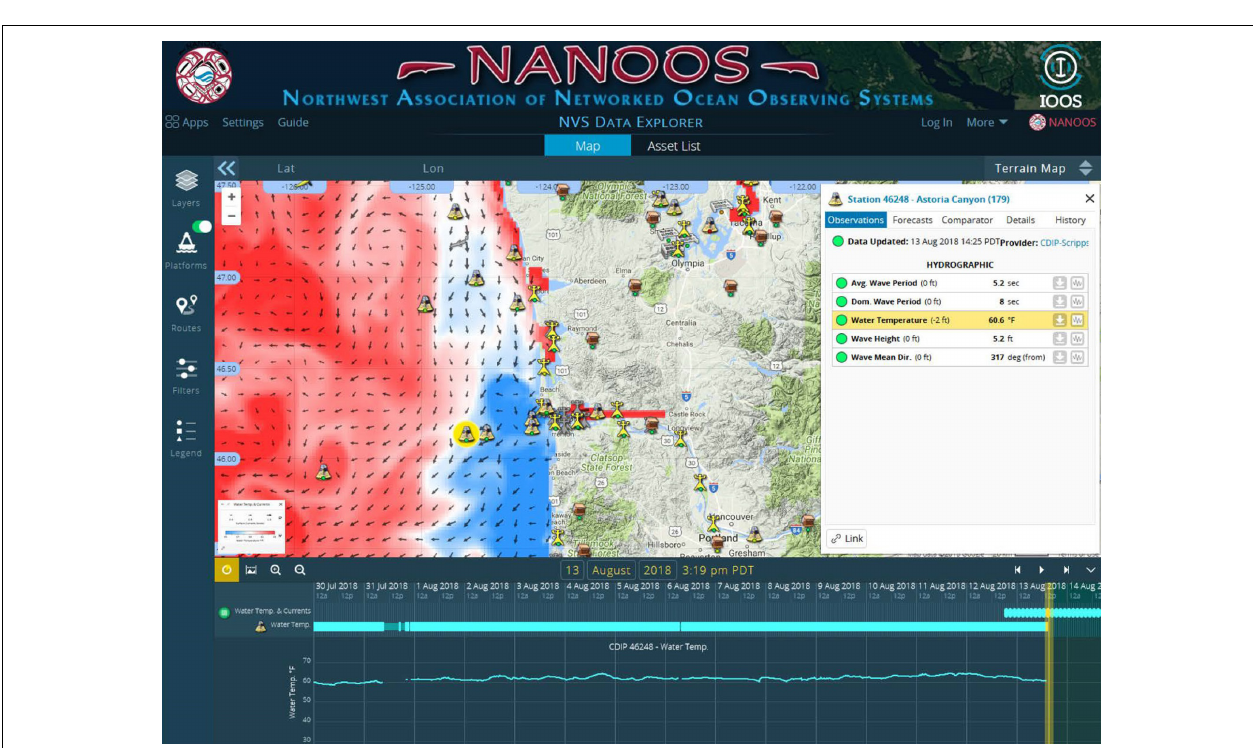
FIGURE 9 | Screenshot of the winds observed at the IMOS Darwin National Reference Station in Darwin Harbor, Northern Australia, during the passage of Tropical Cyclone Marcus in March 2018 (A) and a tweet generated to publicize the recorded event (B) . These data have improved the utility of a new East Arm wharf development where safe shipping movements have increased from 15 to 60% of the time. Source: IMOS.